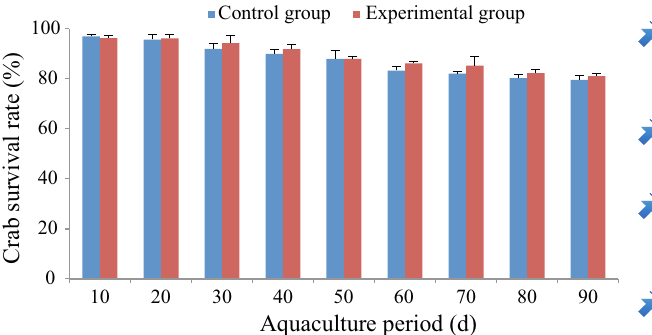
Fig. 6. Survival of crabs with practical application of biochar- immobilized ammonia nitrogen and phosphate removal strains (ANRS and PRS) at 4 g l −1 . Control group did not re- ceive biochar-immobilized ANRS and PRS; experimental group: challenged by biochar-immobilized ANRS and PRS. Error bars: SD; crabs sampled per treatment: 50